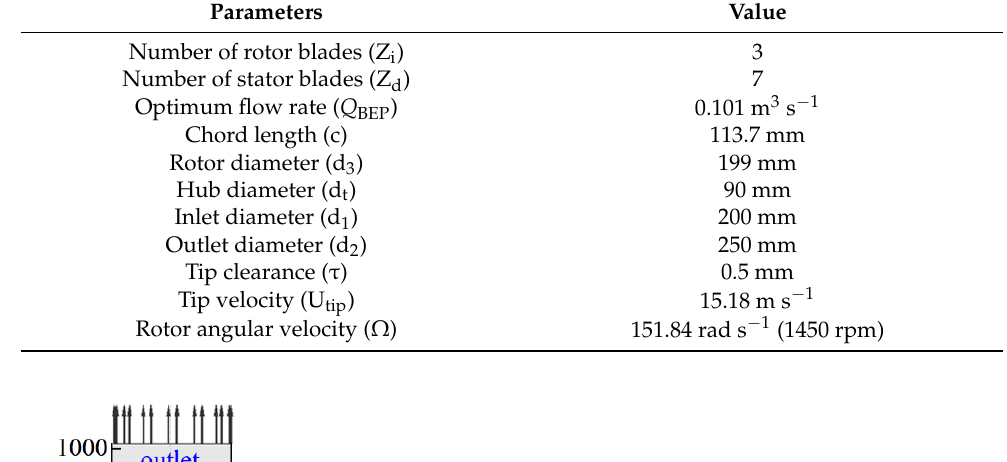
Table 1. Pump geometry and reference data.